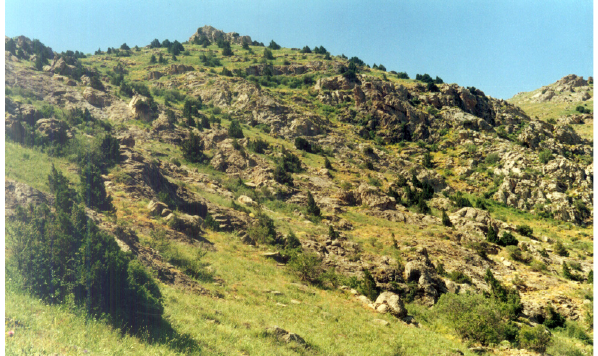
Fig. 5 . Salix community